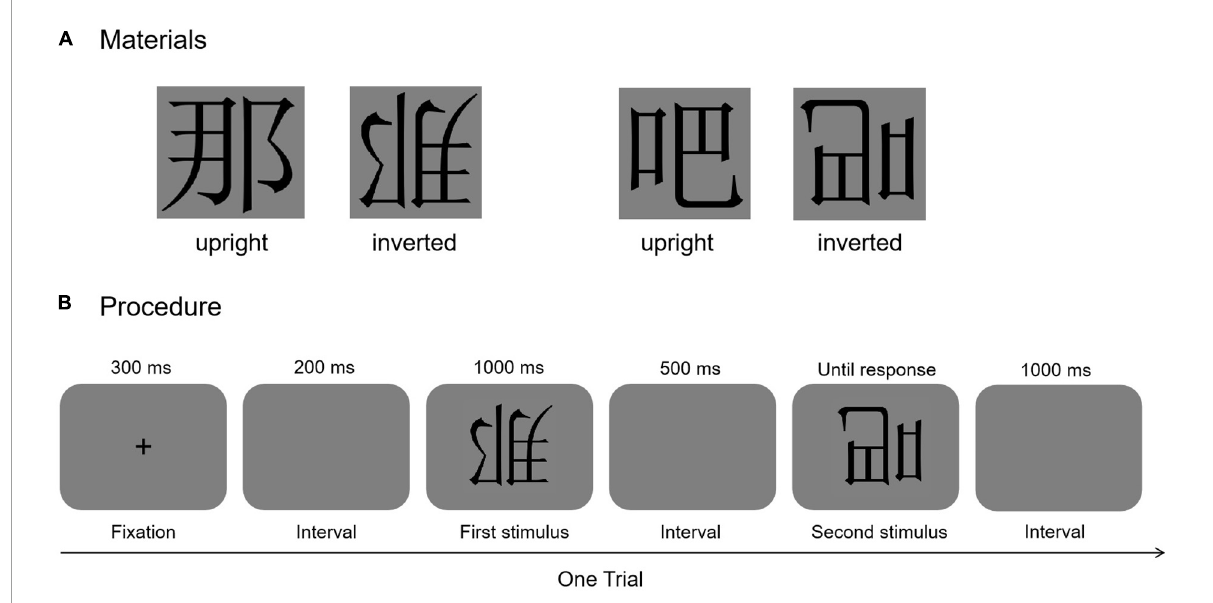
FIGURE1 (A) Examples for upright and inverted Chinese characters. (B) The trial structure of the inversion task.